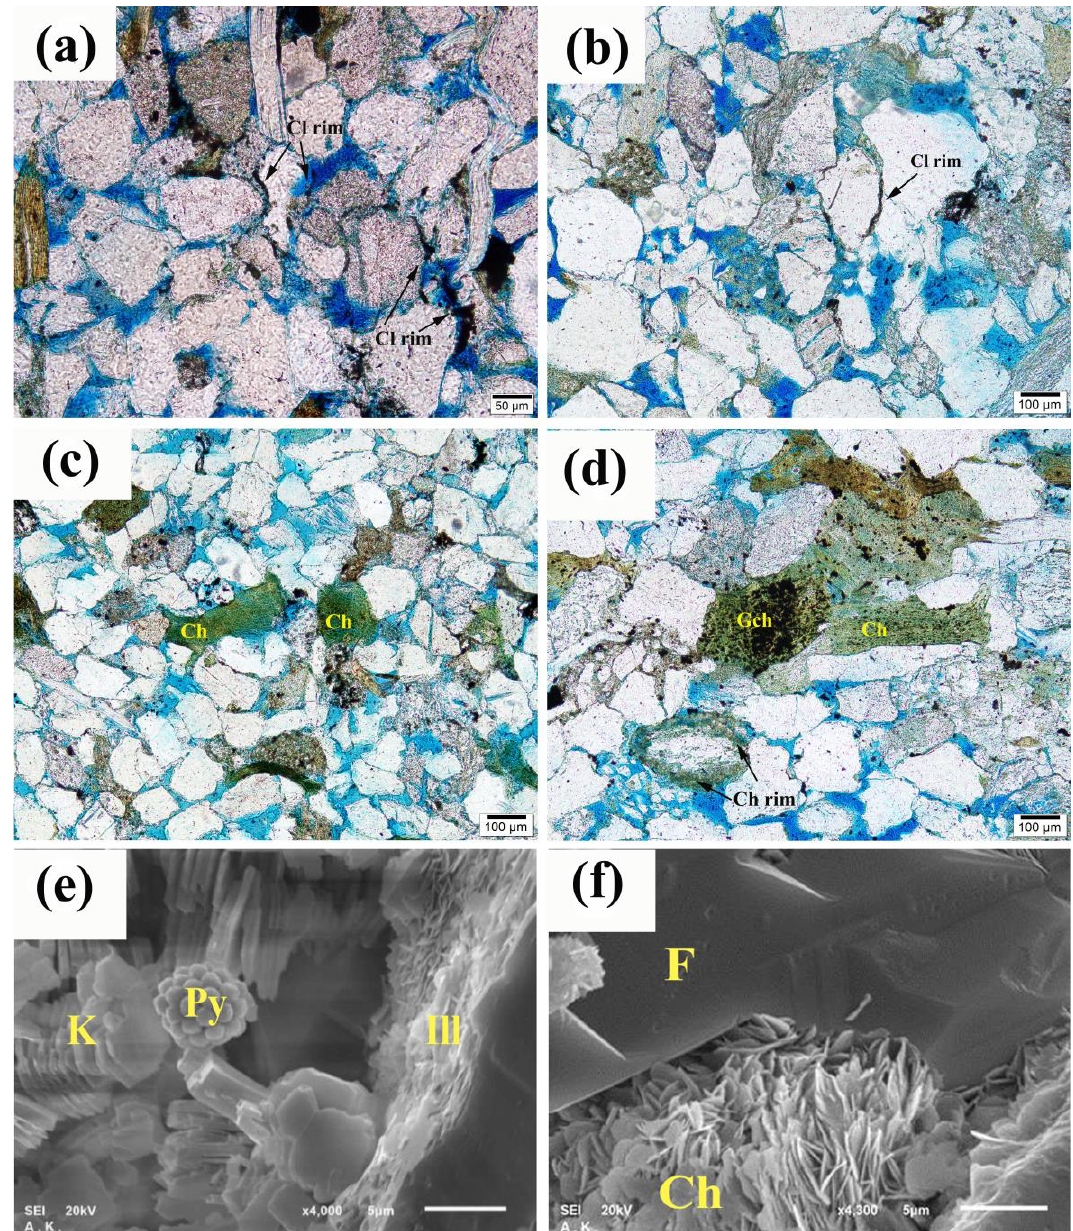
Figure 10. Photomicrograph showing ( a ) pore-filling and grain-coating clay at 3086.5 m depth; ( b ) clay rim at 3182 m depth; ( c) pore- filling and grain coating chlorite at 3084.5 m depth; ( d ) chlorite rim and grain coating chlorite at 3184.5 m depth; SEM showing ( e ) kaolinite clay (K) with pyrite crystal (Py) and Illite (Ill); ( f ) pore- filling chlorite (Ch) and well-developed feldspar overgrowth (F) [4]). Carbonate